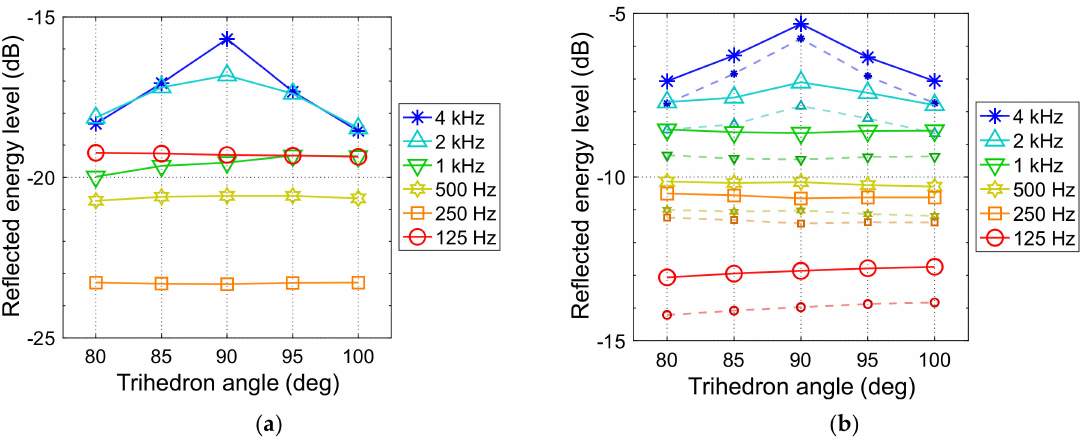
Figure 10. Reflected energy level at the source position (P1 only) from FDTD simulations, for concave trihedral corner angles varied from 80 ◦ to 100 ◦ : ( a ) Panna Meena ka Kund (partial model, without ground reflection); ( b ) Lahan Vav (full model)—for which large markers include the ground reflection and small markers (dashed lines) exclude it. Values are expressed relative to the emitted free field energy at 1